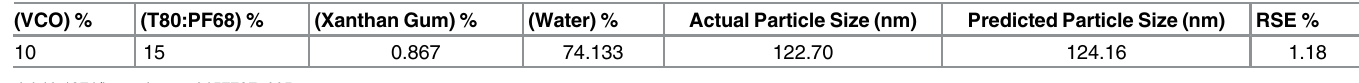
Table 5. The predicted and actual response values for the optimized formulation.